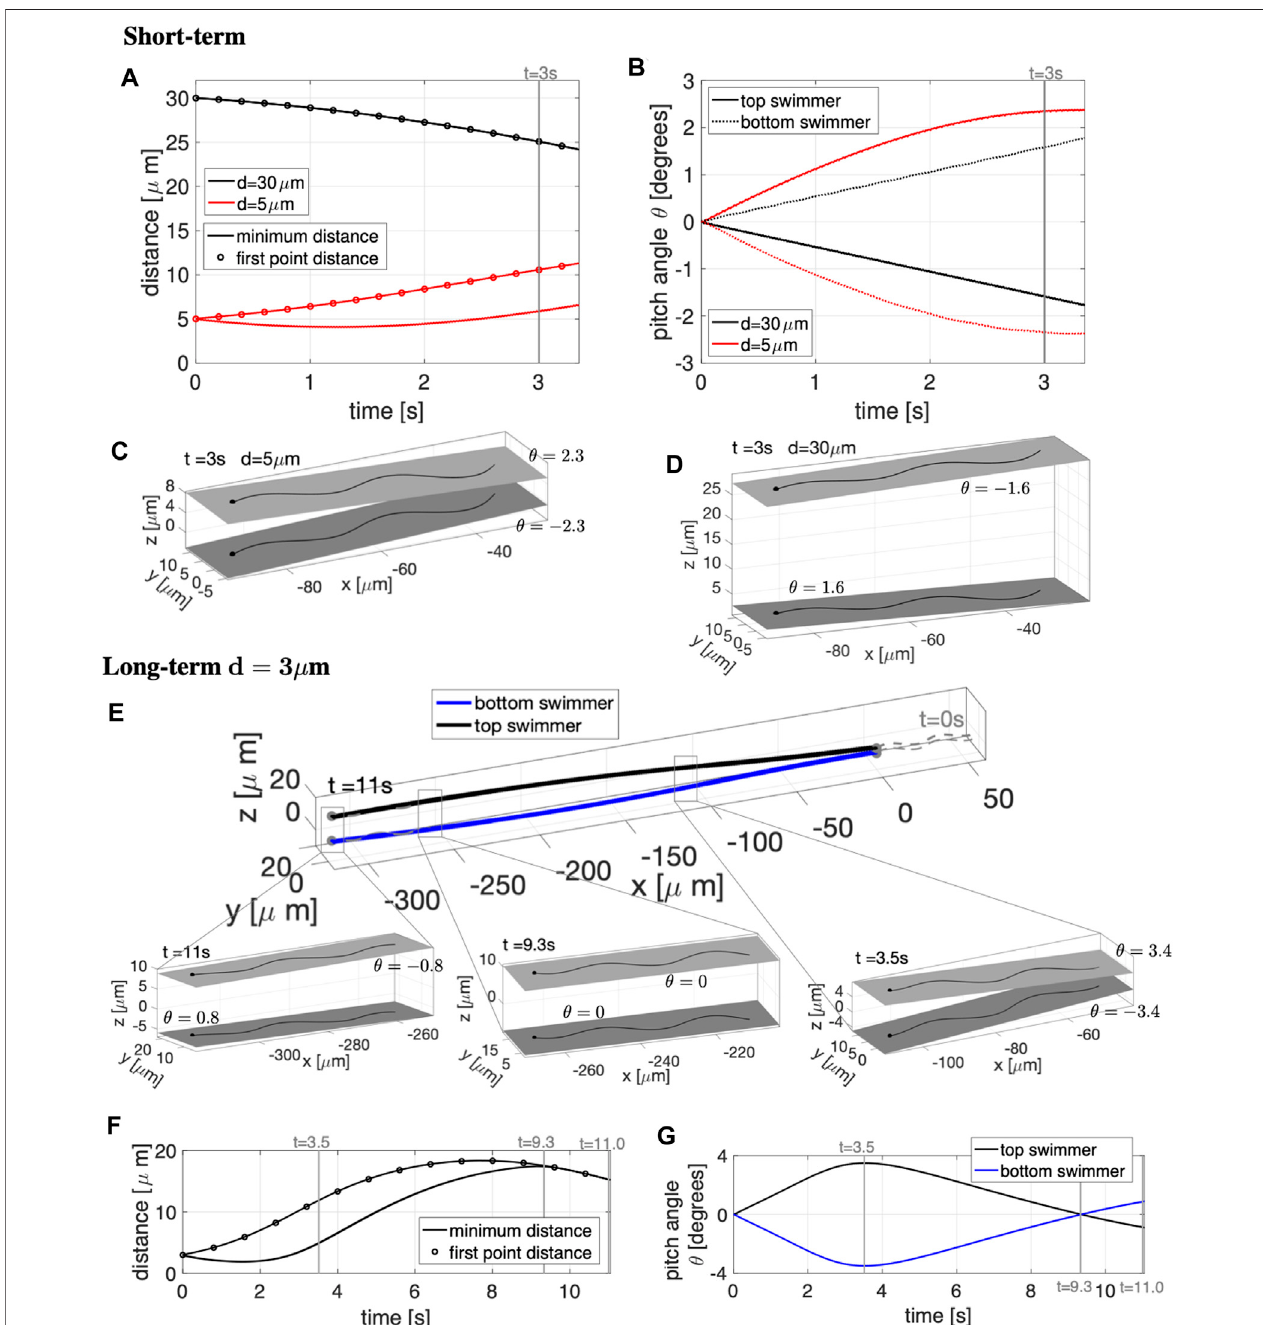
FIGURE 6 | Parallel Sperm in Free Space. Short-term behavior for initial distances d (cid:1) 5, 30 μ m (A – D) and long-term behavior for d (cid:1) 3 μ m (E – G) for swimmers initializedinparallelbeatingplanes.Minimumdistancebetweenthetwoswimmers(solidlines)anddistancebetweenthe fi rstpointsofthetwoswimmers(circles)intime, for initial distances d (cid:1) 5, 30 μ m in (A) and d (cid:1) 3 μ m in (F) . Pitching angle θ of the beating planes of the top and bottom swimmers in time, for initial distances d (cid:1) 5, 30 μ m in (B) and d (cid:1) 3 μ m in (G) . Top and bottom swimmer ’ s beating planes and pitching angles θ for d (cid:1) 5 μ m in (C) and d (cid:1) 30 μ m in (D) at time t (cid:1) 3 s. (E) Swimmer con fi gurations at t (cid:1) 0 s (gray dashed lines) and traces of the swimmers initial points in time (colored solid lines). Top and bottom swimmer ’ s beating planes and pitching angles θ forthreesnapshotsintime arereportedinthecorrespondingzoomed portions.Thetimeschosenforthezoomed portions of (E) areidenti fi edwith vertical gray lines in (F , G) . In (C , D , E) , a fi lled in sphere is used to denote the swimmer fi rst point in the direction of motion.